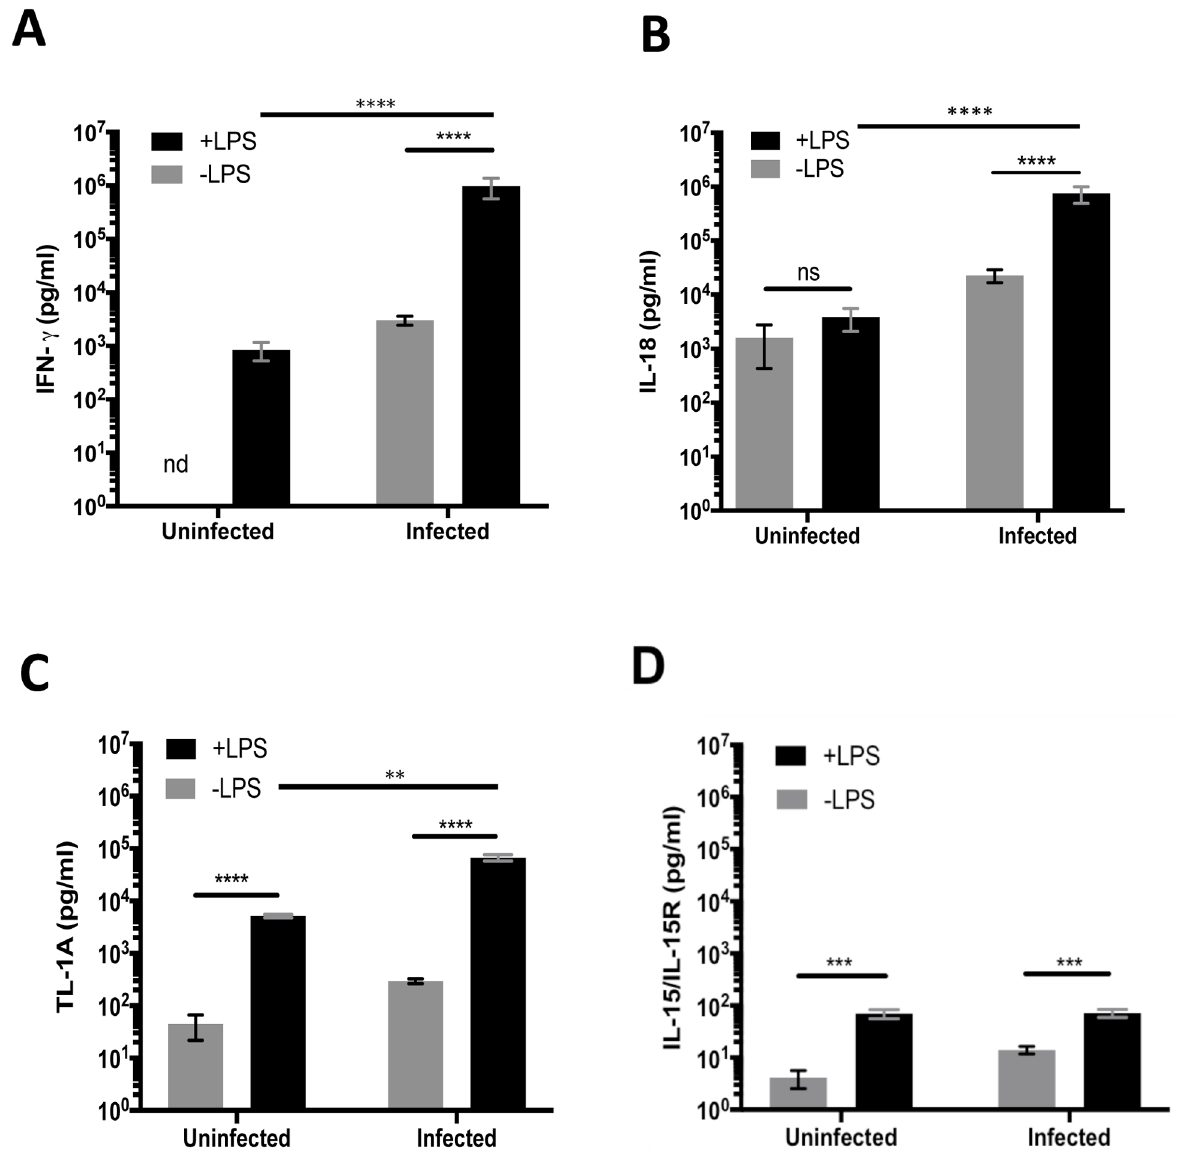
Fig 3. LPS induces elevated serum cytokines. C57BL/6 mice were infected intravenously (i.v.) with 5 × 10 5 Salmonella Typhimurium, and two weeks later, infected or uninfectedmice were injected(i.v.) with LPS. Serum was collected4 hours later for determining cytokine concentration by ELISA. Graphs show concentration of serum IFN- γ (A), IL-18 (B), TL1A (C), and IL-15 (D). Data shown were combined from two experiments containing at least three mice per group (nd = nonedetected). Statistical analyseswere performed by two-way ANOVA with a Bonferroni posttest. Error bars represent the mean ± SEM. p < 0.0001 ( **** ),0.0002 ( *** ), 0.0021( ** ), 0.0332( * ),